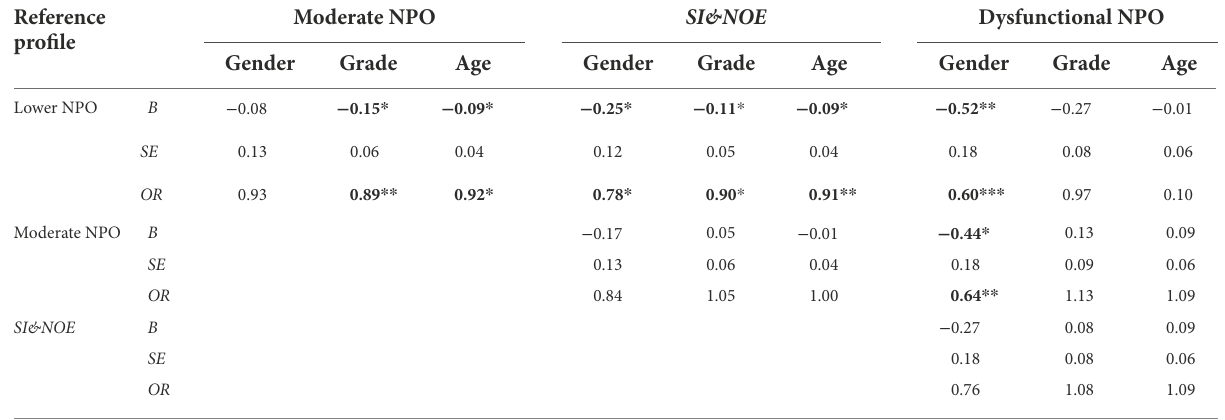
TABLE 3 Multinomial logistical regression results predicting the four profiles of NPOQ.